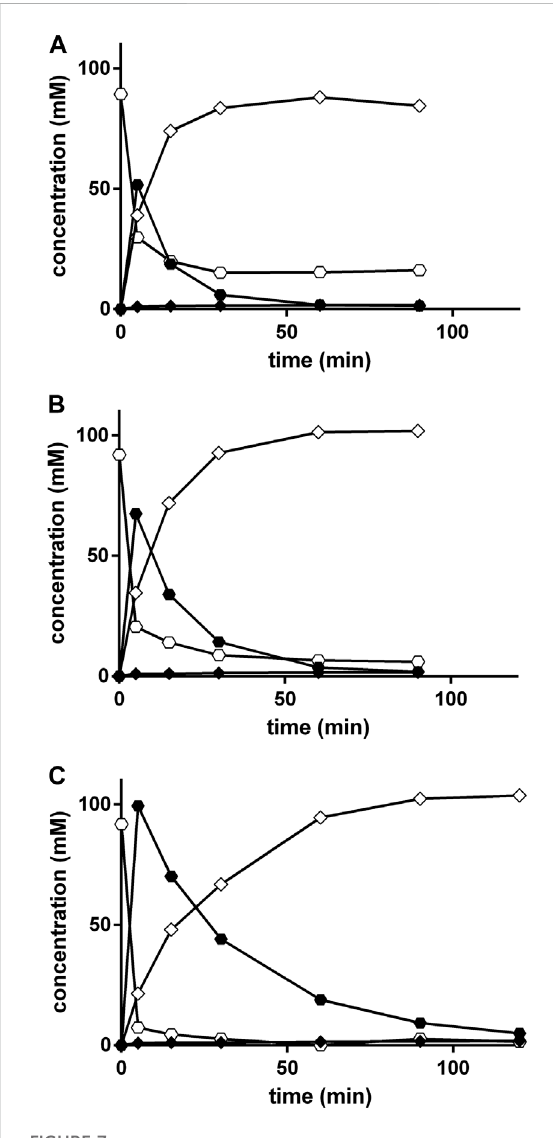
enantiomer (e.g., Ala165Phe) with mutations that result in a “ high amide phenotype ” (e.g., Trp188X) could result in variants with the ability to form in excess ( R )-PGAA.